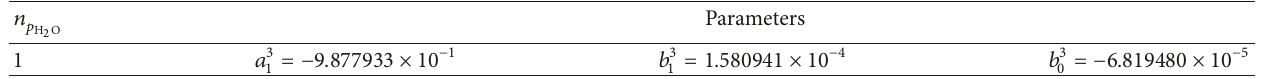
Table 11: Parameters of the reduced-order water pressure model of order 𝑛 𝑝 𝑛 𝑝 H 2 O